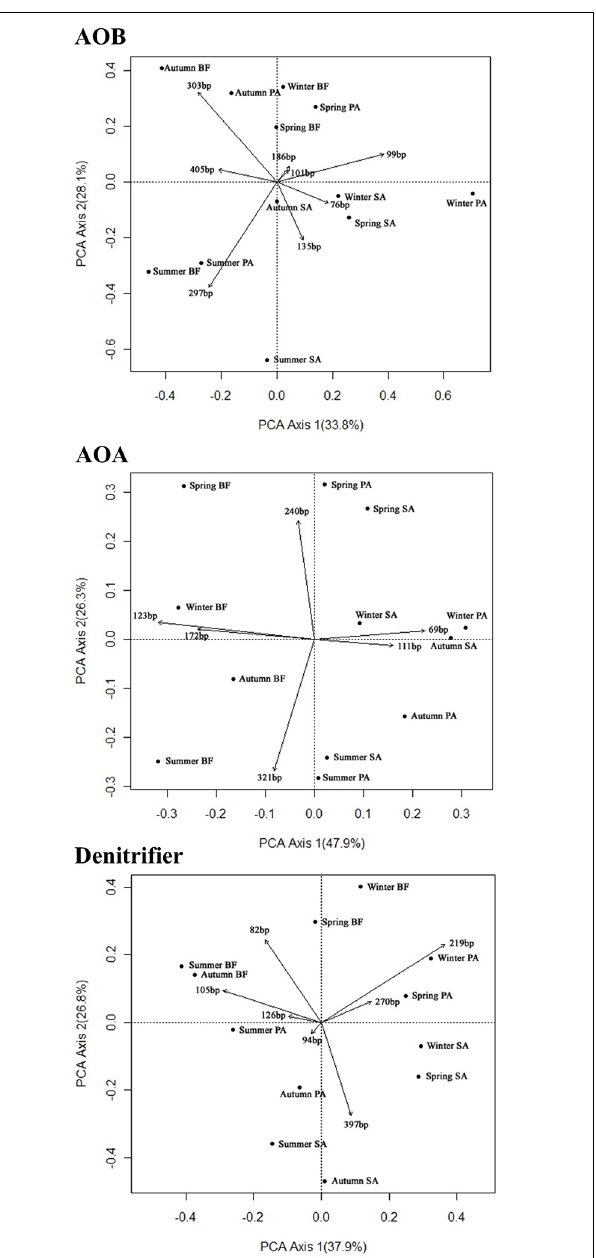
FIGURE 4 | Principal component analysis (PCA) of the sampling sites based on the composition of the AOB, AOA, and denitrifier communities as determined by the T-RFLP analysis. Each vector represents an individual T-RF profile. The values in parenthesis indicate the percentage of community variation explained by the axes. BF, soil at bare flat; SA, soil covered by Spartina alterniflora ; PA, soil covered by Phragmites australis